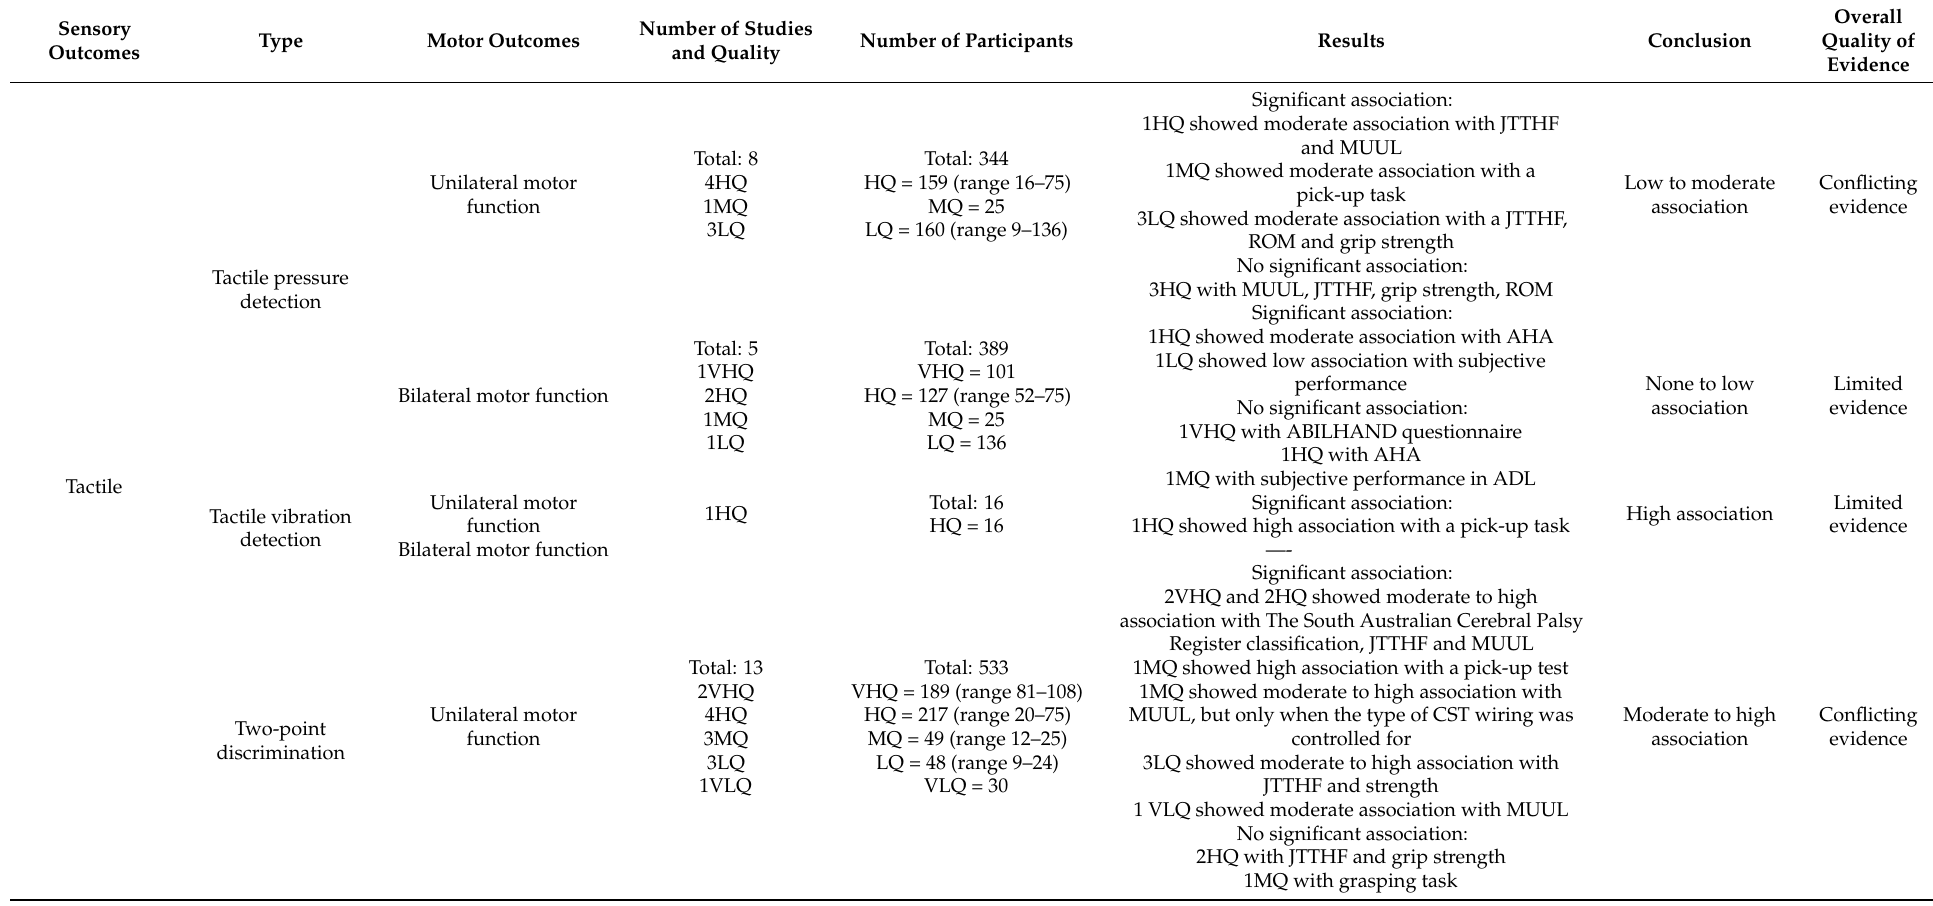
Table 2. Synthesis of conclusion and level of evidence for each combination of sensory and motor